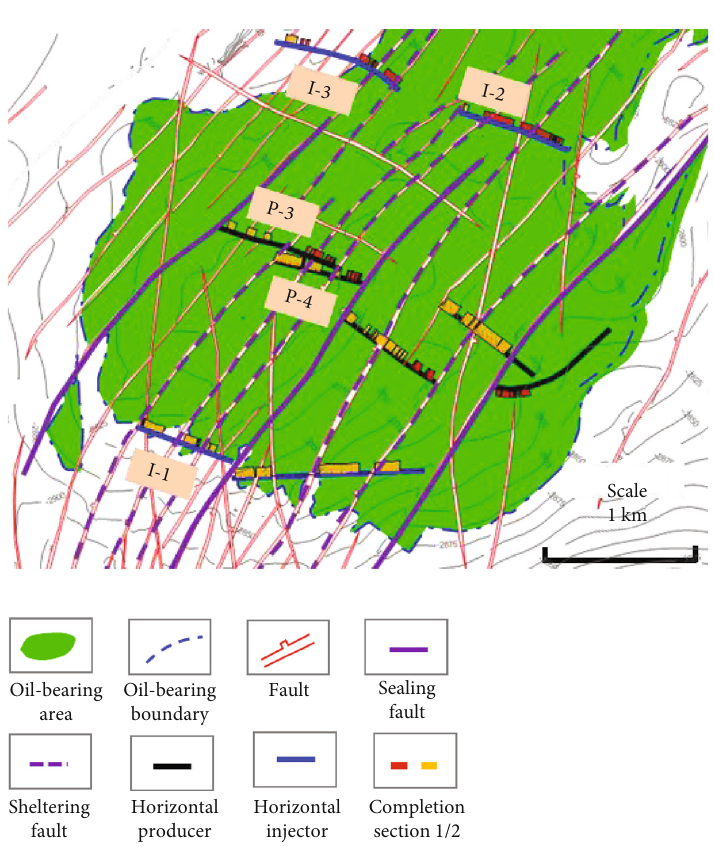
Figure 4: Well location of